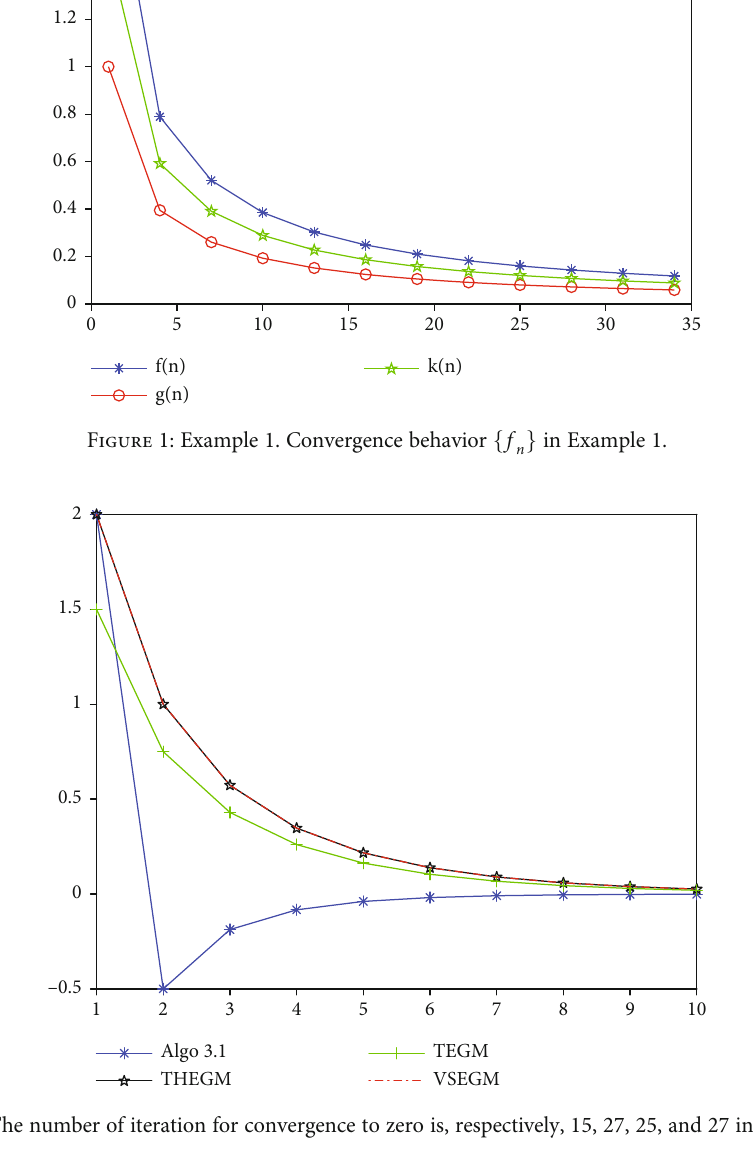
Figure 2: The number of iteration for convergence to zero is, respectively, 15, 27, 25, and 27 in Example